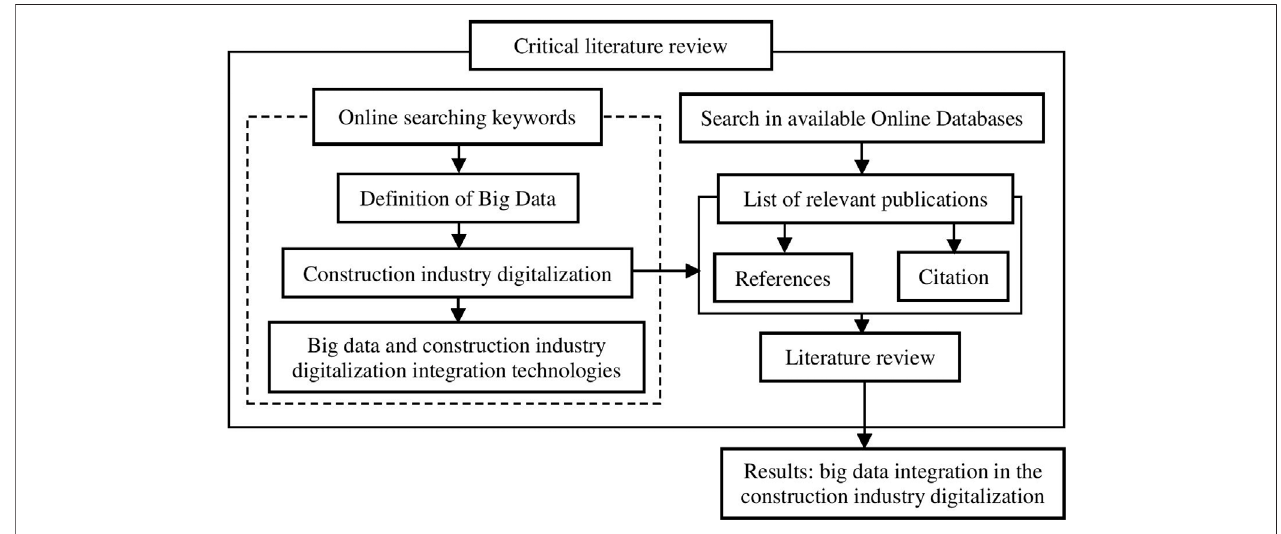
FIGURE 1 | Flowchart of the literature